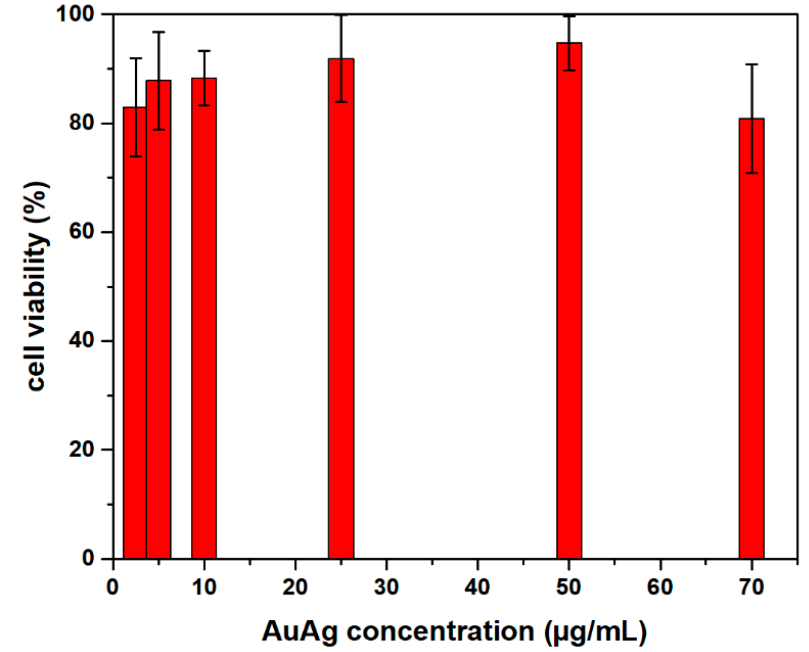
Figure 4. Cell viability (%) of U-87 cells determined using MTT assay after 24 h incubation with or AuAgNTrs in the concentration range 2.5–70 µ g AuAg/mL ( n = 3) normalized to the control that represents 100% viable cells. Data analysis revealed no statistically significant difference in cell viability values between tested groups ( p > 0.05).